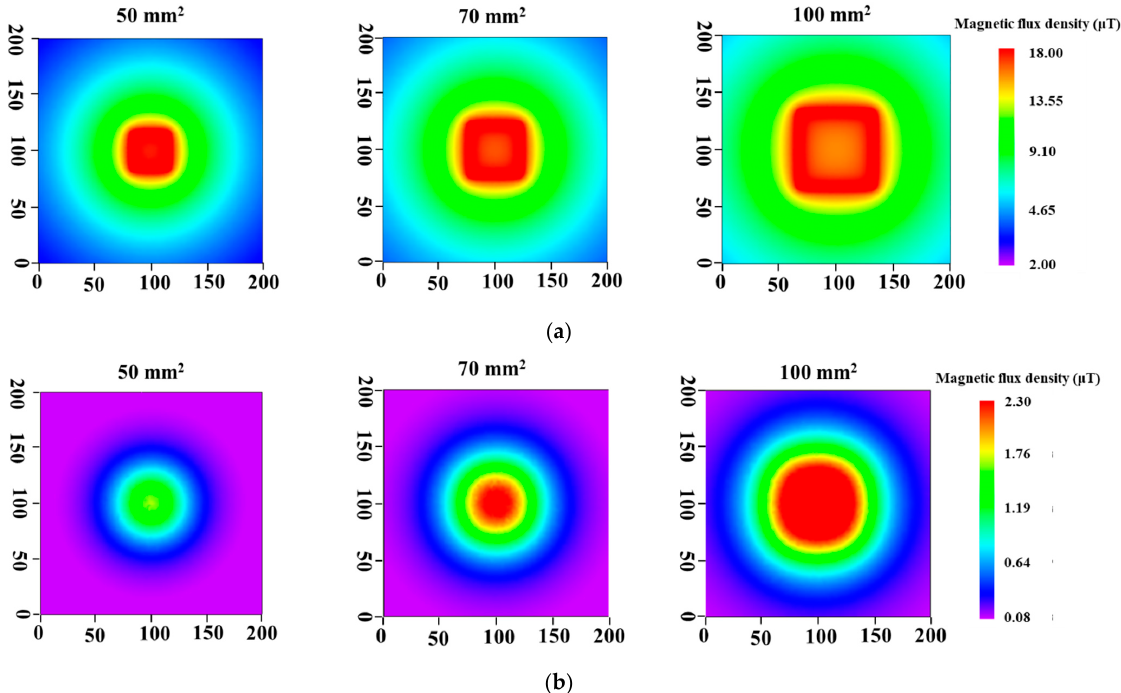
Figure 5. Simulation of magnetic field distributions at lift-offs: ( a ) 0 mm and ( b ) 50 mm. Figure 6 shows the magnetic field distributions measured with the prototype probes.